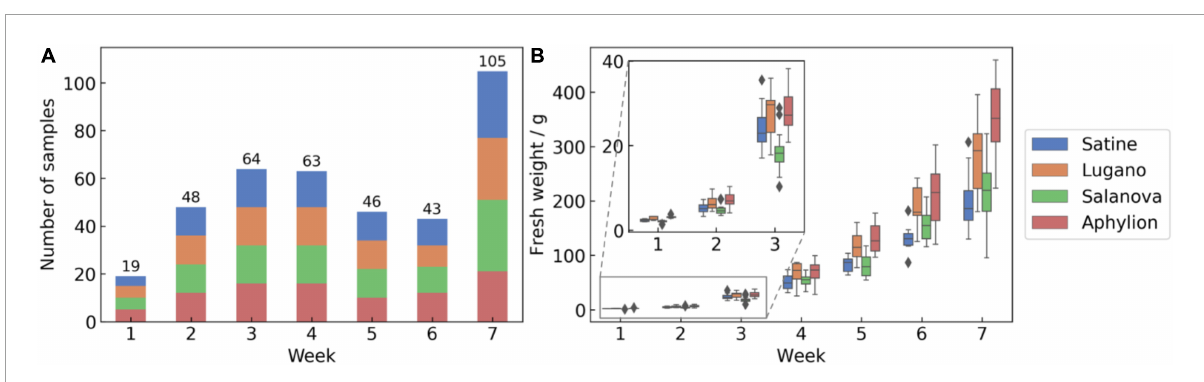
FIGURE4 Data distribution of the AGC dataset: (A) sample size of the four varieties, and (B) fresh weight distribution of the four varieties.